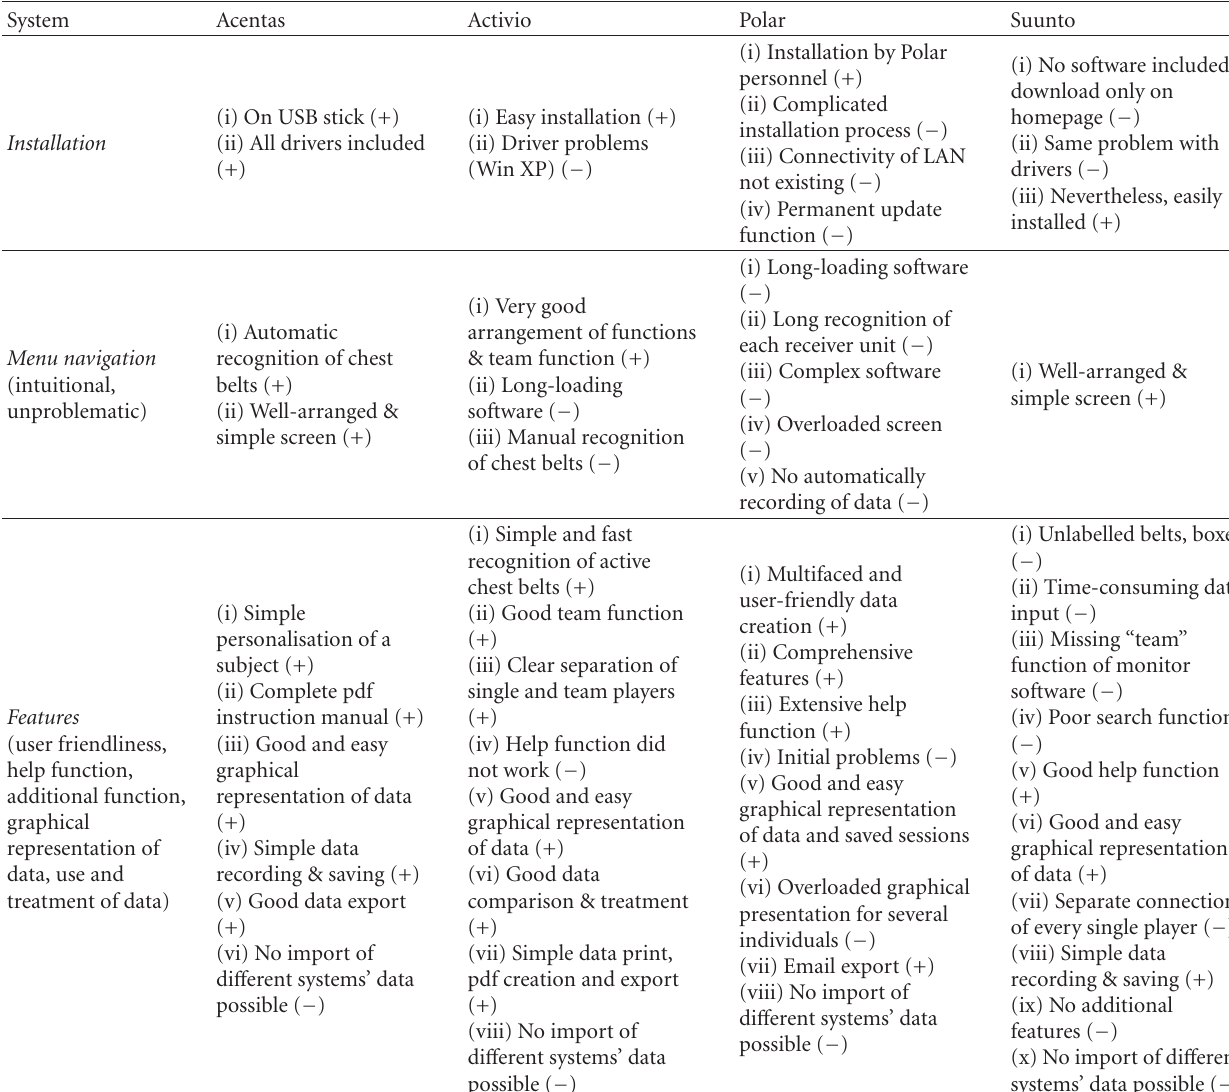
Table 4: Notes on software